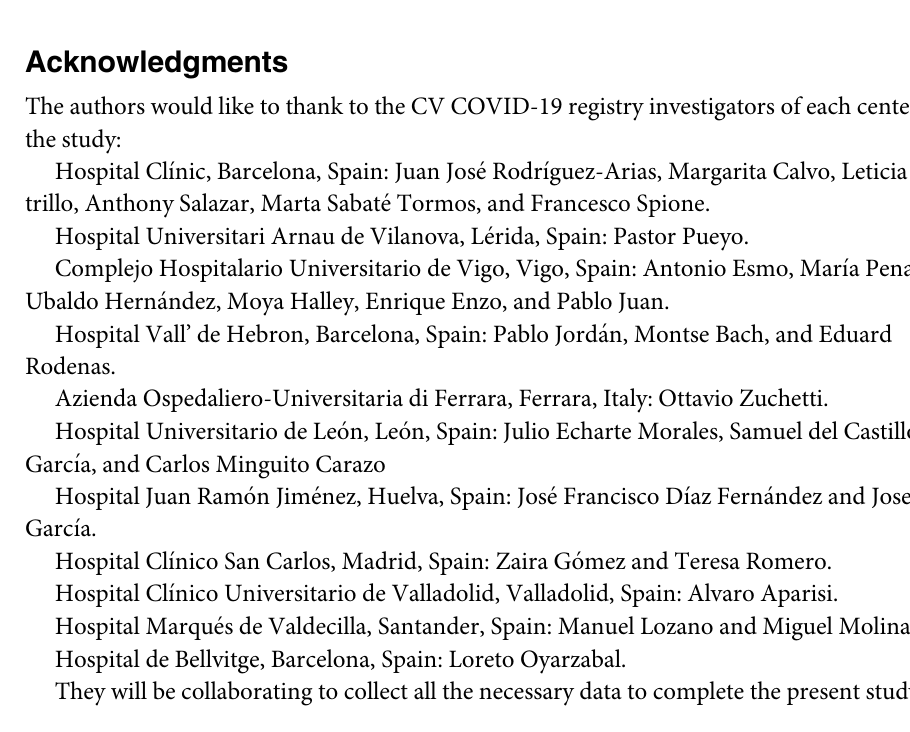
S1 Table. List of committees and